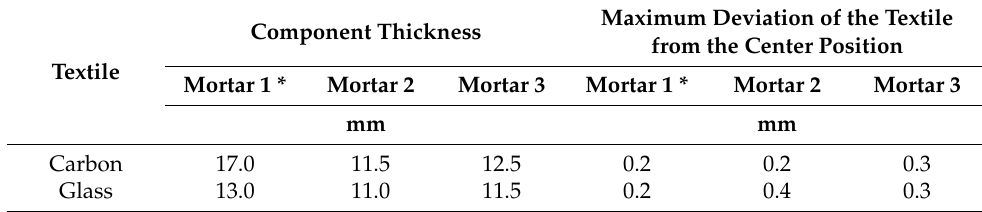
Maximum Deviation of the Textile from the Center Position